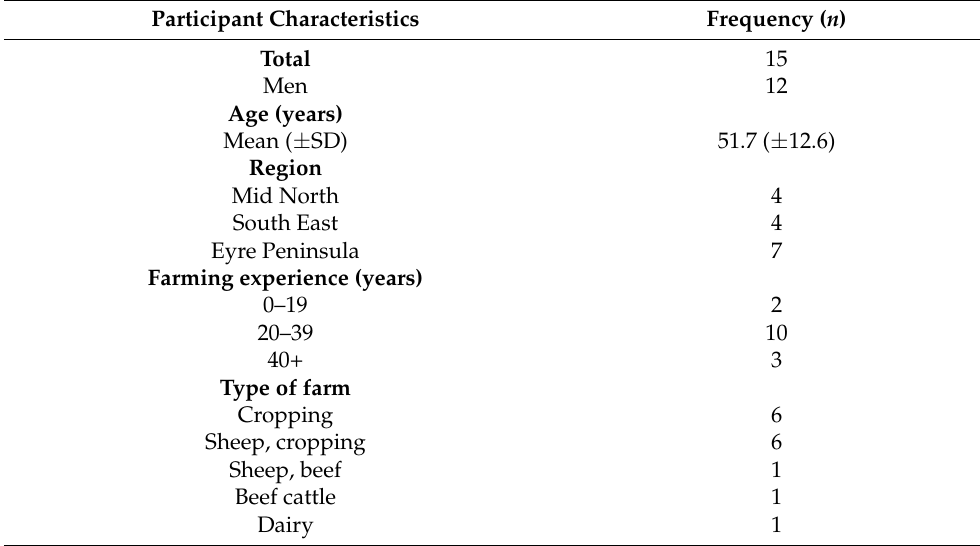
Table 1. Demographic Characteristics of Participants